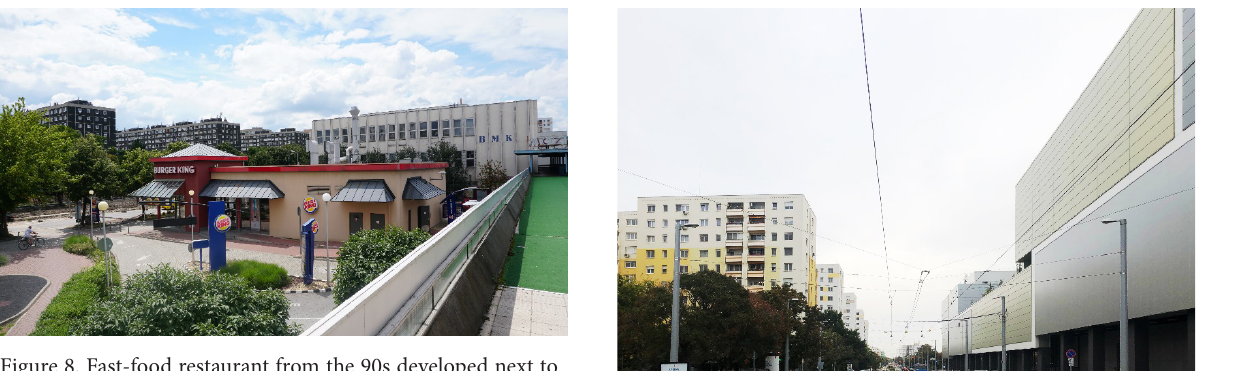
Figure 8. Fast-food restaurant from the 90s developed next to former cultural centre Kelenföld LHE, 2022 (source: author)